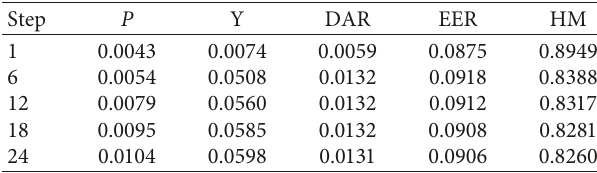
Table 5: Forecast error variance